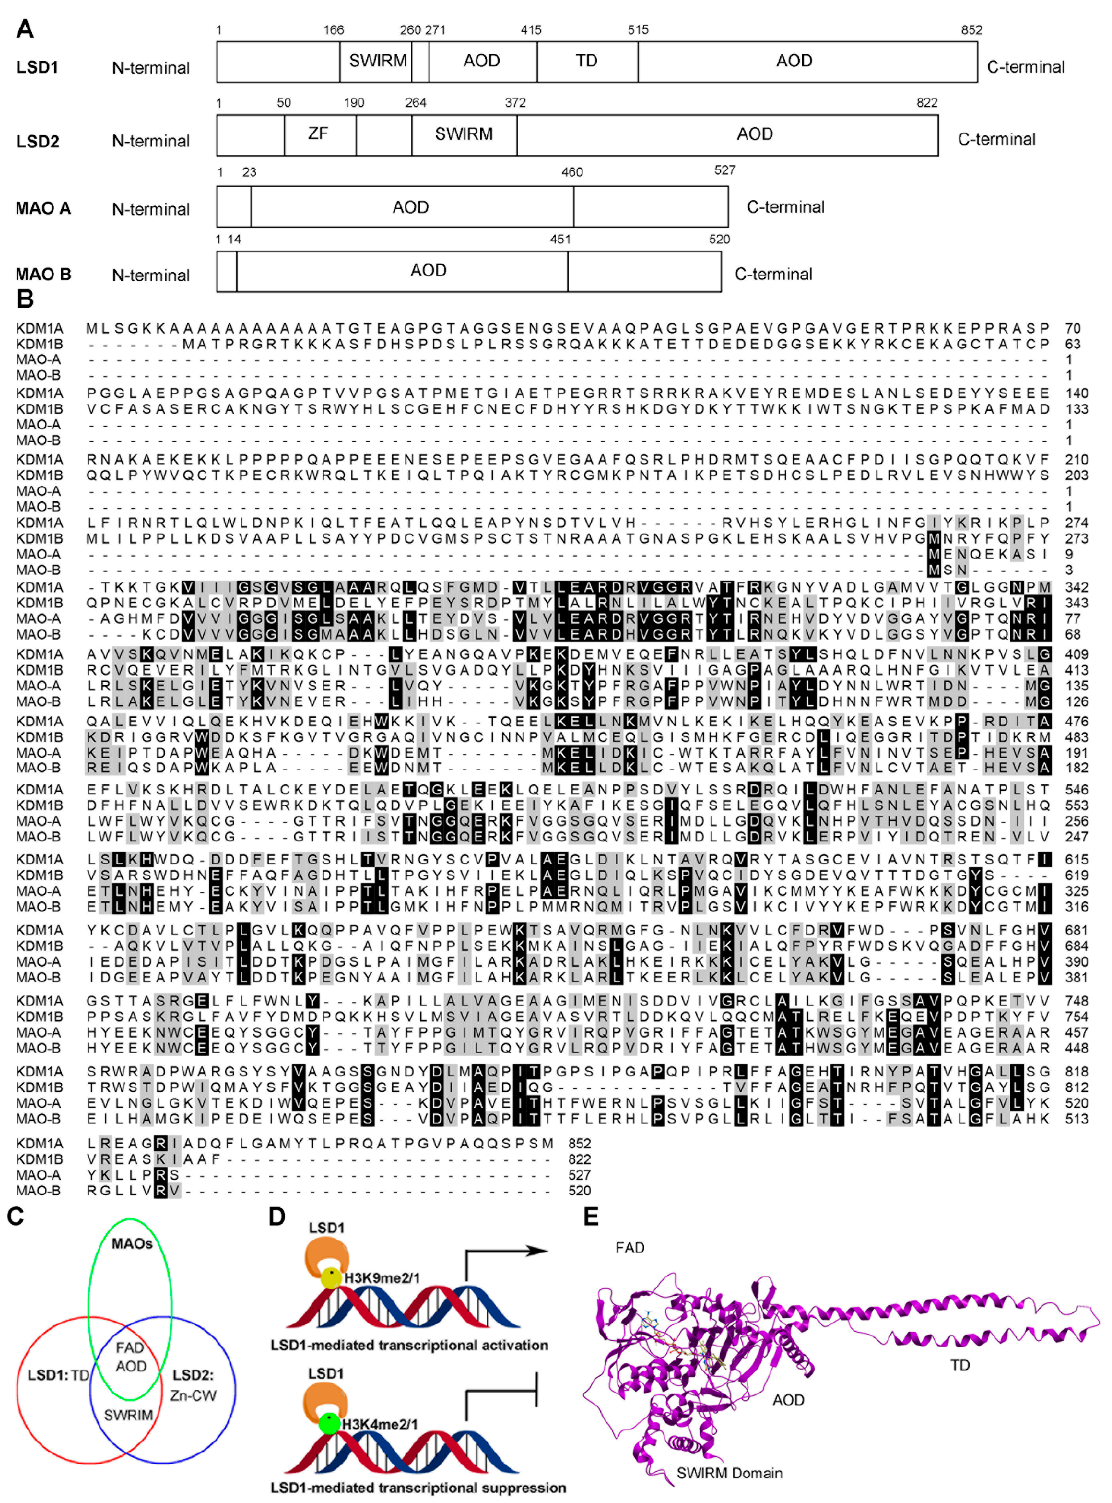
Figure 2. The structure and function of LSD1. ( A ) Domain architectures of four human FAD-dependent oxidation enzymes: LSD1, LSD2, MAO A, and MAO B. ( B ) Multiple alignment between amine oxidase domains of LSD family and MAOs from human beings. ( C ) Comparison of the domains of the LSD family and MAOs. FAD: FAD binding motif; TD: tower domain; Zn-CW: Zinc-finger domain. ( D ) LSD1-mediated transcriptional modulation. ( E ) Overall structure of LSD1 with trans-2-pentafluorophenylcyclopropylamine (2-PFPA); domains are labeled as in ( A ).